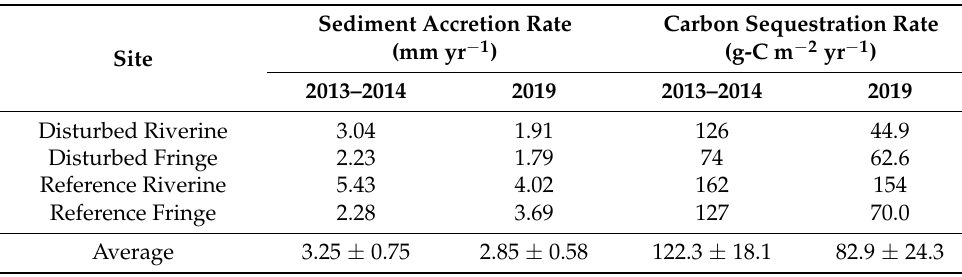
Table 3. Sediment accretion rate and carbon sequestration rate in 2013–2014 [10] and 2019 (this study) in the disturbed and reference